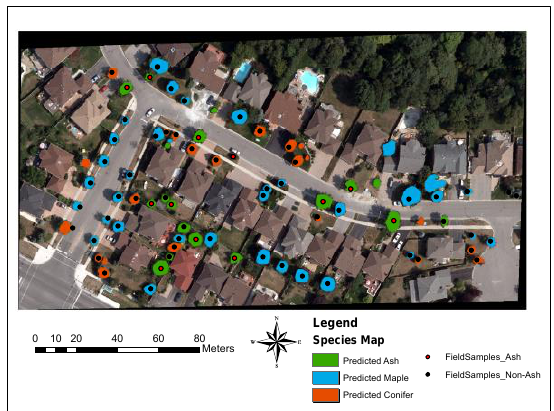
Figure 7. The identified ash trees in Site 2 by thresholding the regression